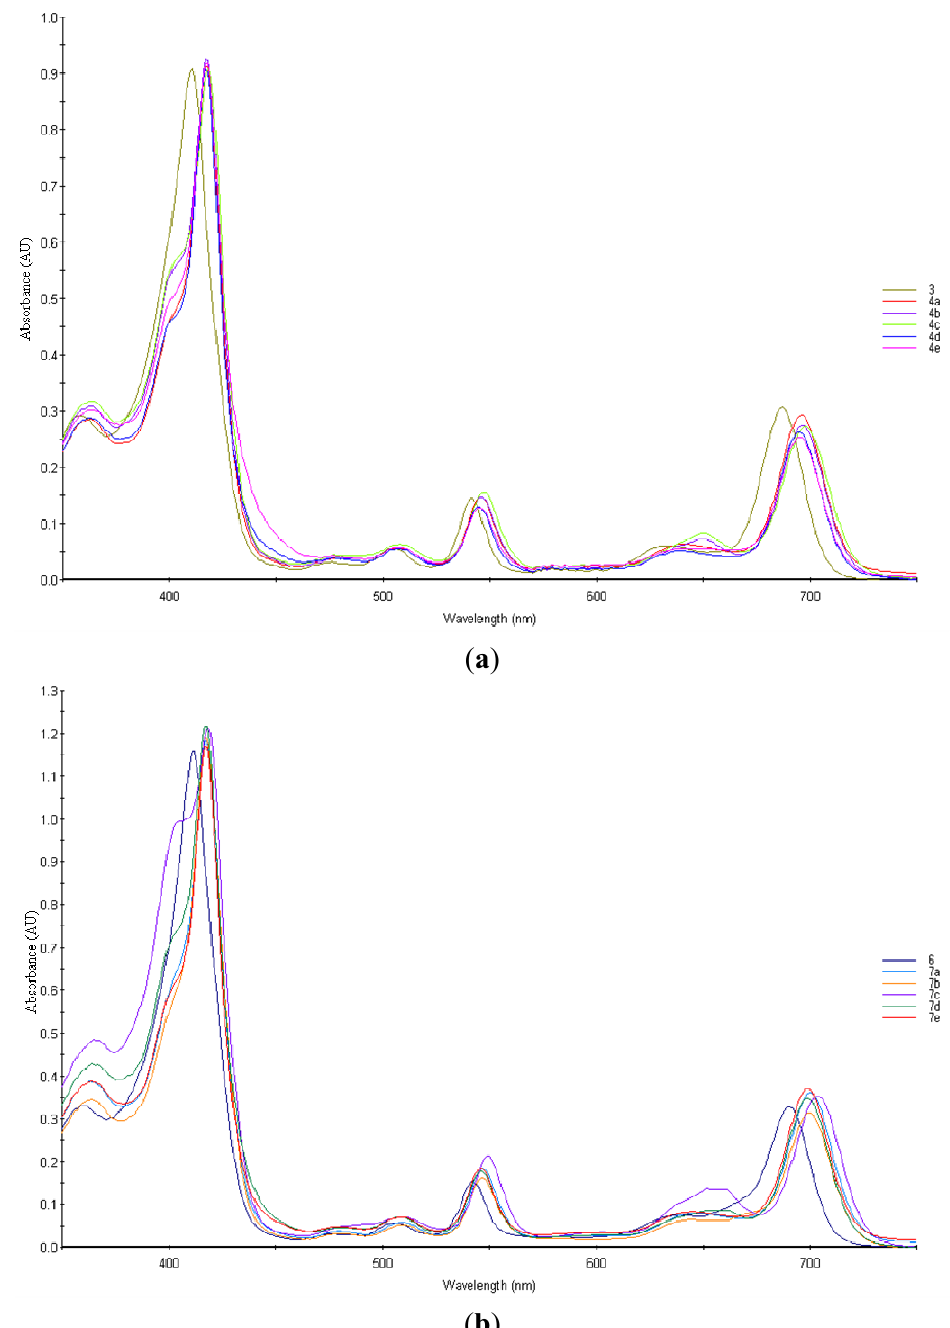
Figure 2. Electronic absorption spectra of purpurinimides for ( a ) 3 , 4a – 4e ; and ( b ) 6 , 7a – 7e in CH Cl 2 2